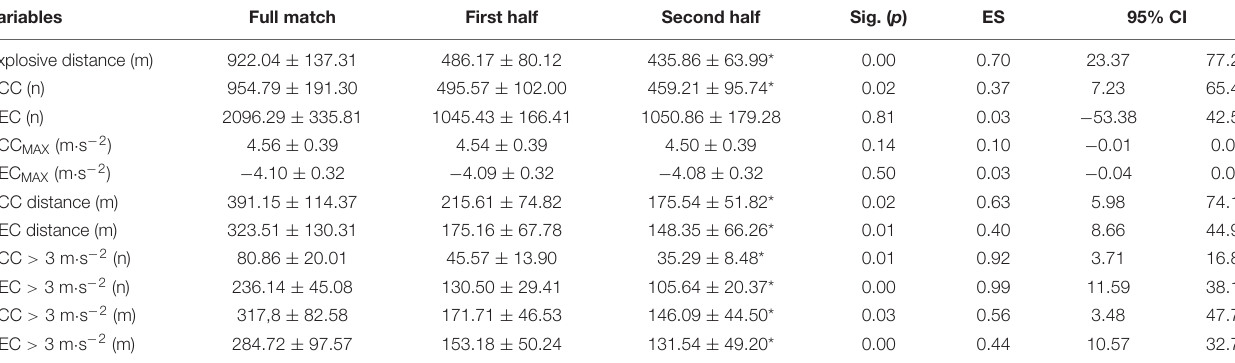
TABLE 2 | Acceleration and deceleration demands of referees during match.